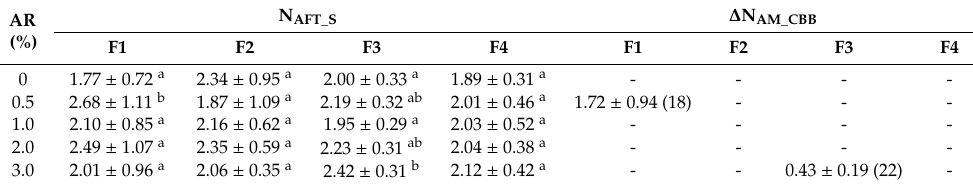
Di ff erent lower-case superscript letters in a column indicate significant di ff erences. ∆ N AM_CBB was calculated by using the same plus or minus sign figures between di ff erent lower-case superscript letters in a column. The number in parenthesis indicates the data number used for